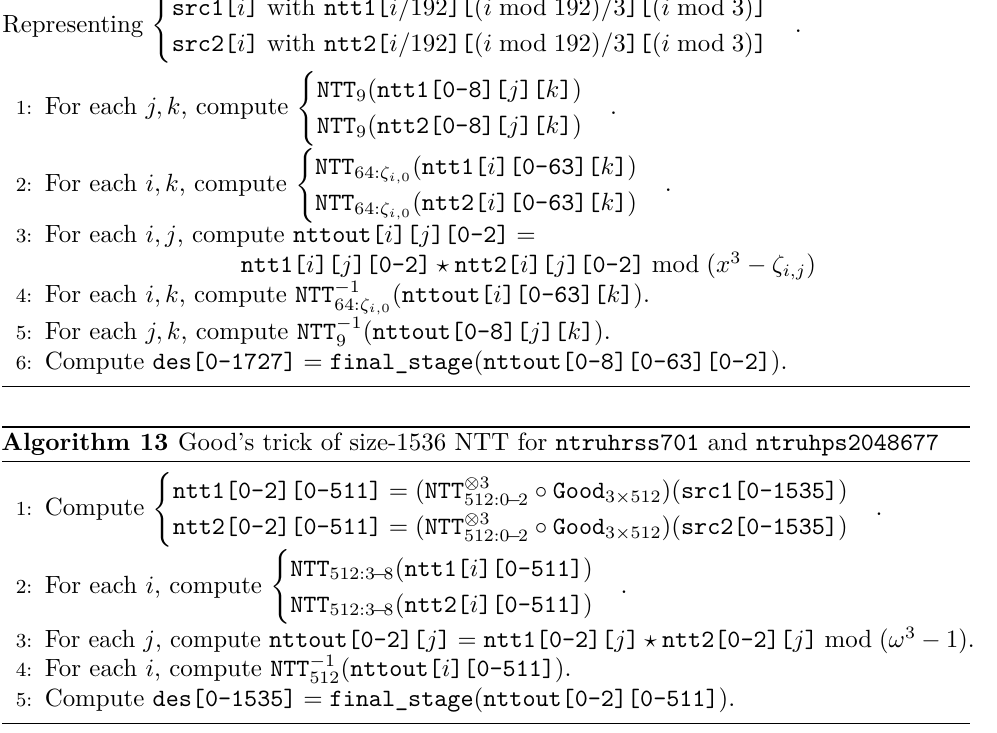
Algorithm 12 Incomplete mixed-radix size-1728 NTT for ntruhps4096821 Representing